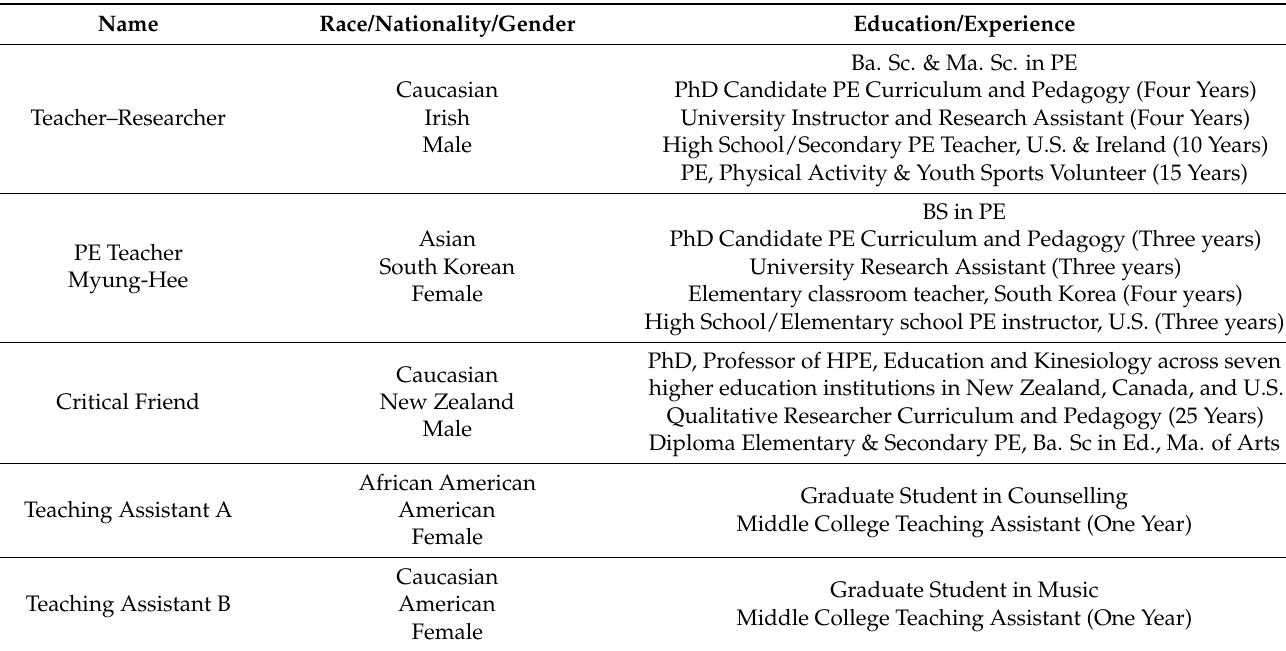
Table 1. Adult Participant Details.